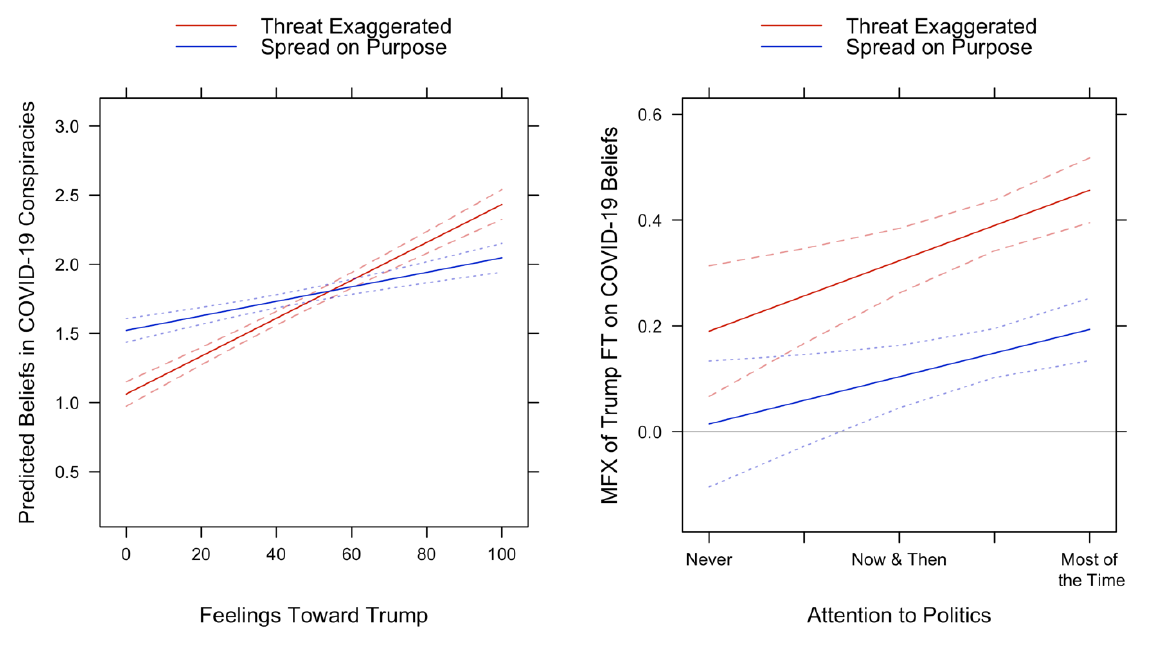
Figure 4. Relationship between COVID-19 conspiracy beliefs and Trump support. Predicted effects of Trump support (left) and marginal effects of Trump support conditional on attention to politics (right) on beliefs that COVID-19 “threat is exaggerated” and was “spread on purpose,” controlling for other